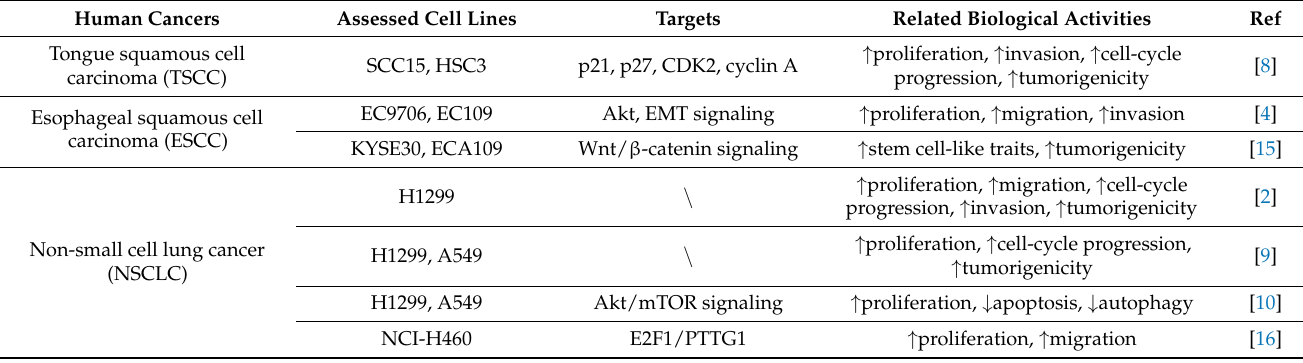
Figure 2. PRR11 involved oncogenic signaling pathways and biological molecules in cancers. EMT, PI3K/AKT/mTOR, Wnt/ β -catenin signalings and biological molecules, including MMP2, TIMP-2, p21, p27, CDK2, cyclin A2, CTHRC1, LXN, EGR1, UCHL1, SNAT1 and PTTG1, were involved in the functional process of PRR11, including stemness, proliferation, migration, invasion, cell-cycle, apoptosis, autophagy, tumorigenesis and chemotherapy resistance. Abbreviations: PRR11 , proline rich 11; MMP2 , matrix metallopeptidase 2; TIMP-2 , tissue inhibitor of metalloproteases 2; CDK2 , cyclin-dependent kinase 2; CTHRC1 , collagen triple helix repeat containing 1; LXN , latexin; EGR1 , early growth response protein 1; UCHL1 , ubiquitin carboxyl-terminal hydrolase 1; SNAT1 , system a amino acid transporter 1; ZEB1 , zinc finger E-box binding homeobox 1. Table 1. Biological activities of PRR11 in cancers.